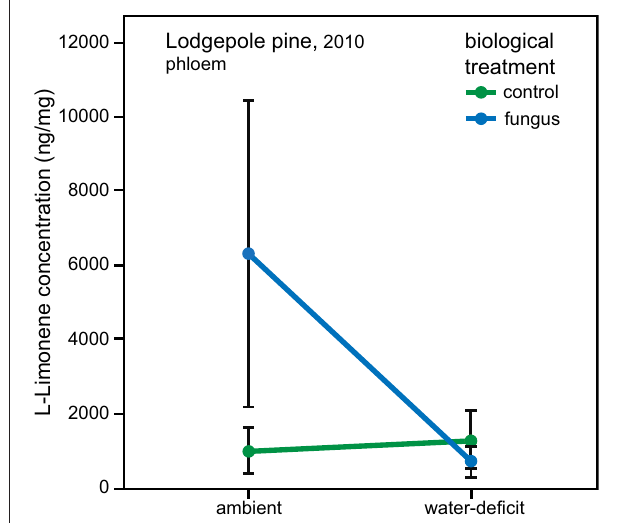
FIGURE 4 | Interaction effect of water and biological treatment on L-limonene concentration in phloem of lodgepole pine ( P. contorta ). Error bars represent bootstrapped 95% CI, non-overlapping error bars indicate a significant